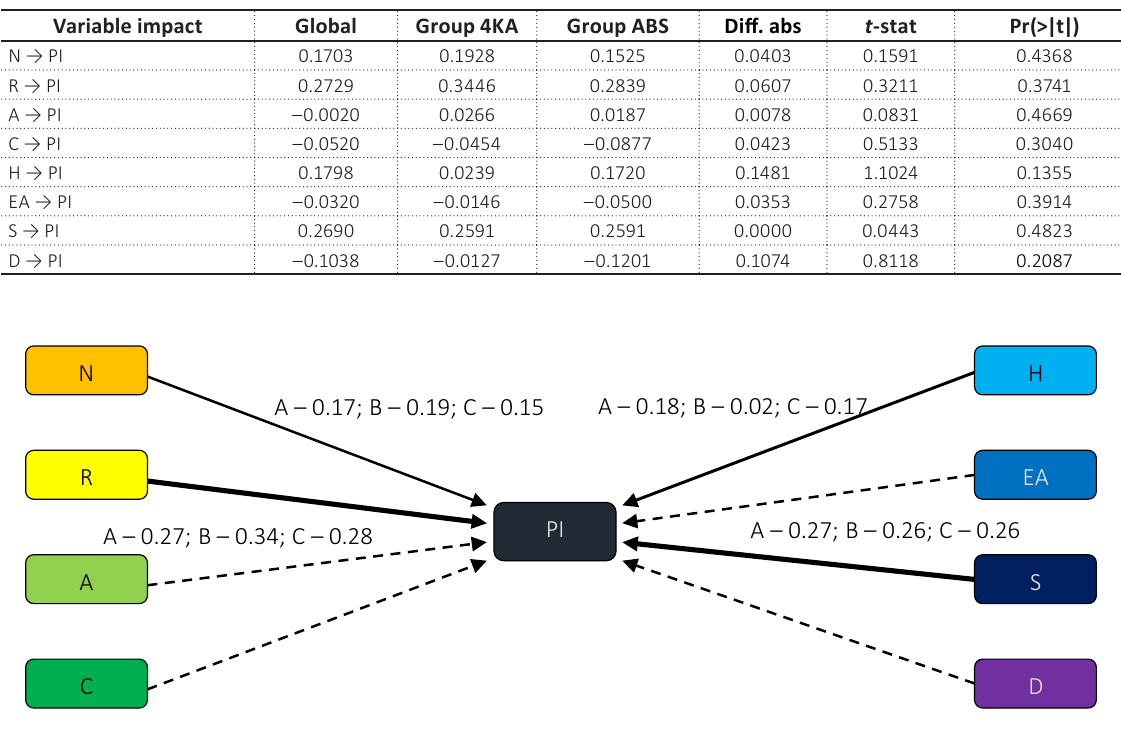
Figure 3. Coefficient scheme PLS PM model whole, 4KA, ABSOLUT